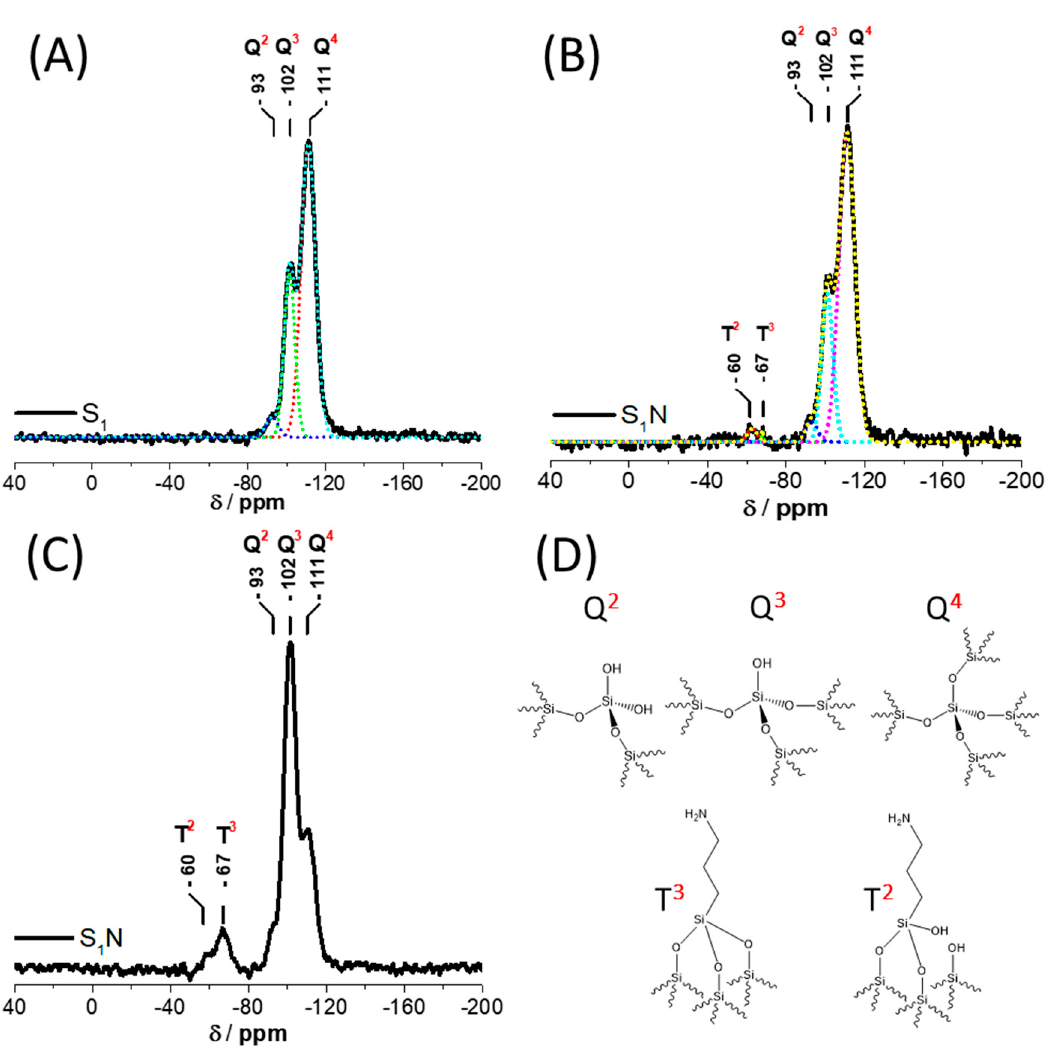
Figure 2. 29 Si MAS NMR spectra of ( A ) S 1 and ( B ) S 1 N; the dashed lines represent deconvoluted curves obtained by using a Gaussian function. ( C ) 29 Si { 1 H} CP / MAS NMR spectrum of S 1 N. ( D ) Illustration of Q 2, 3, 4 and T 2, 3 groups.